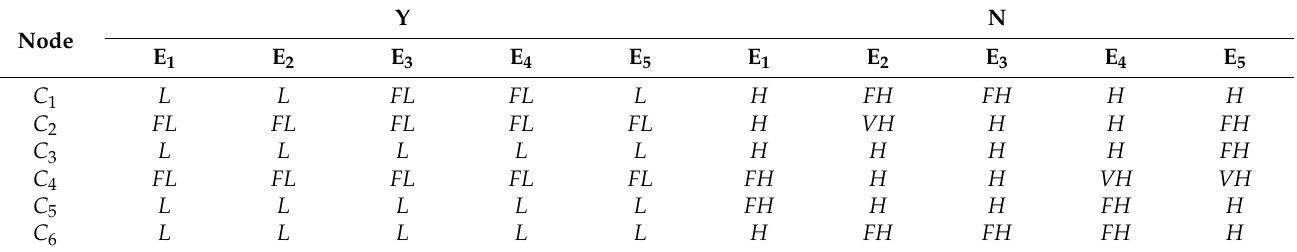
Table 8. Expert fuzzy evaluation table of exogenous variables for catenary construction risks.